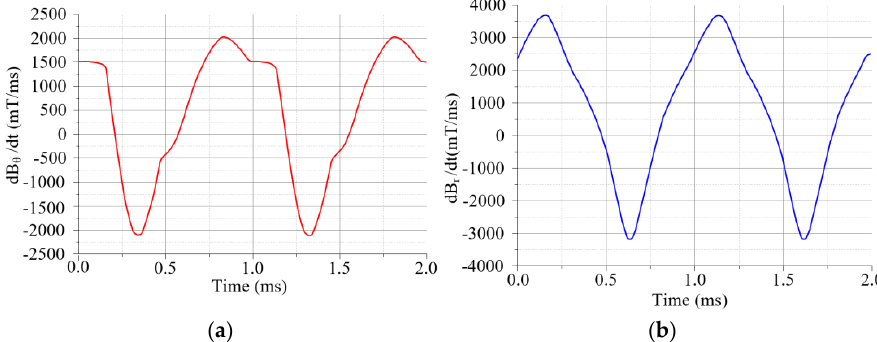
Figure 13. The first derivative of the radial and axial flux density in the inner rotor core. ( a ) Radial. ( b ) Axial.